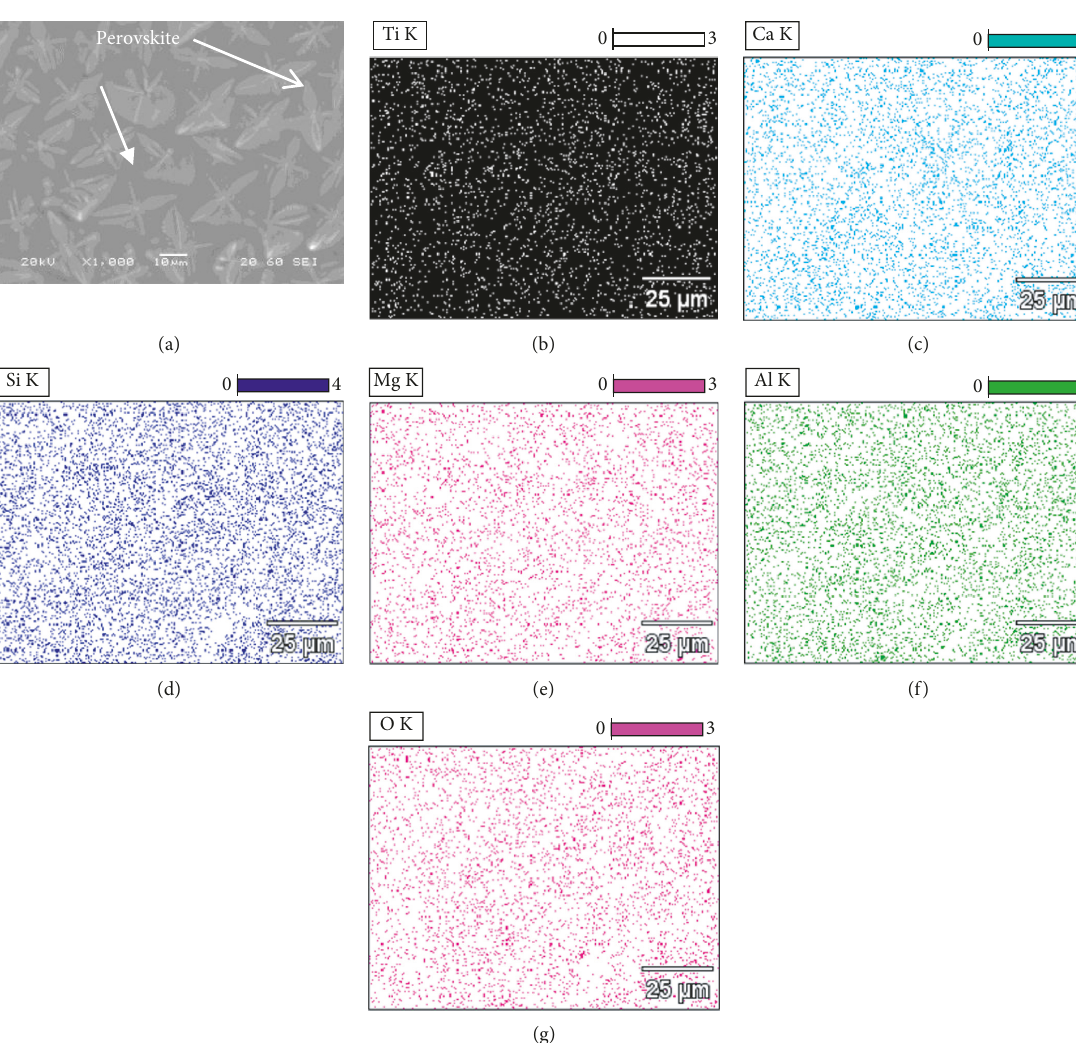
° C. 2 O 3 at 1485